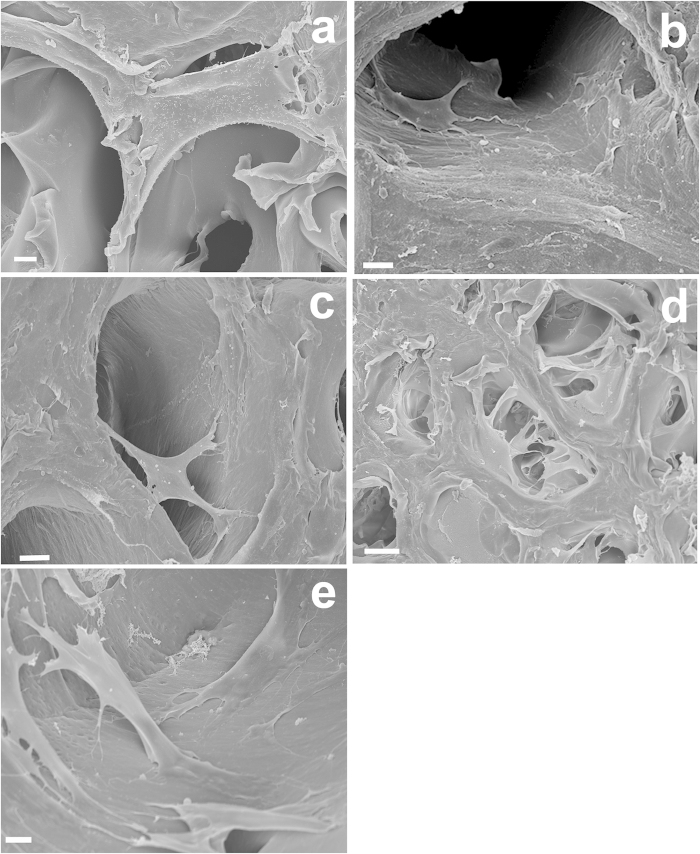
SEM micrographs of PDPCs seeded for 7 days on the different Gel scaffolds. (a) 0/100; (b) 10/90; (c) 25/75; (d) 60/40; (e) 70/30. Scale bars 10 μm.